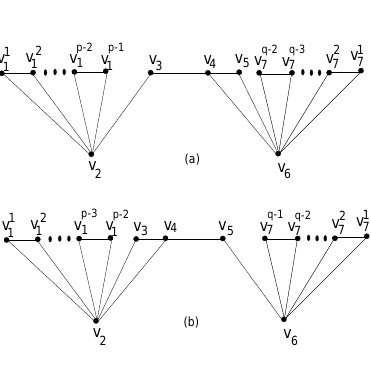
Figure 1: (a) C 1 ( p , q ) and (b) C (cid:48) 1 ( p , q ) .